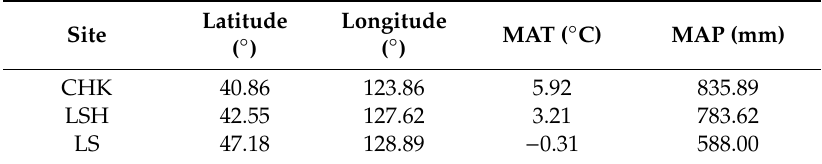
Table 1. Geographic coordinates, mean annual temperature (MAT), and mean annual precipitation (MAP) at three sites in Northeast China.